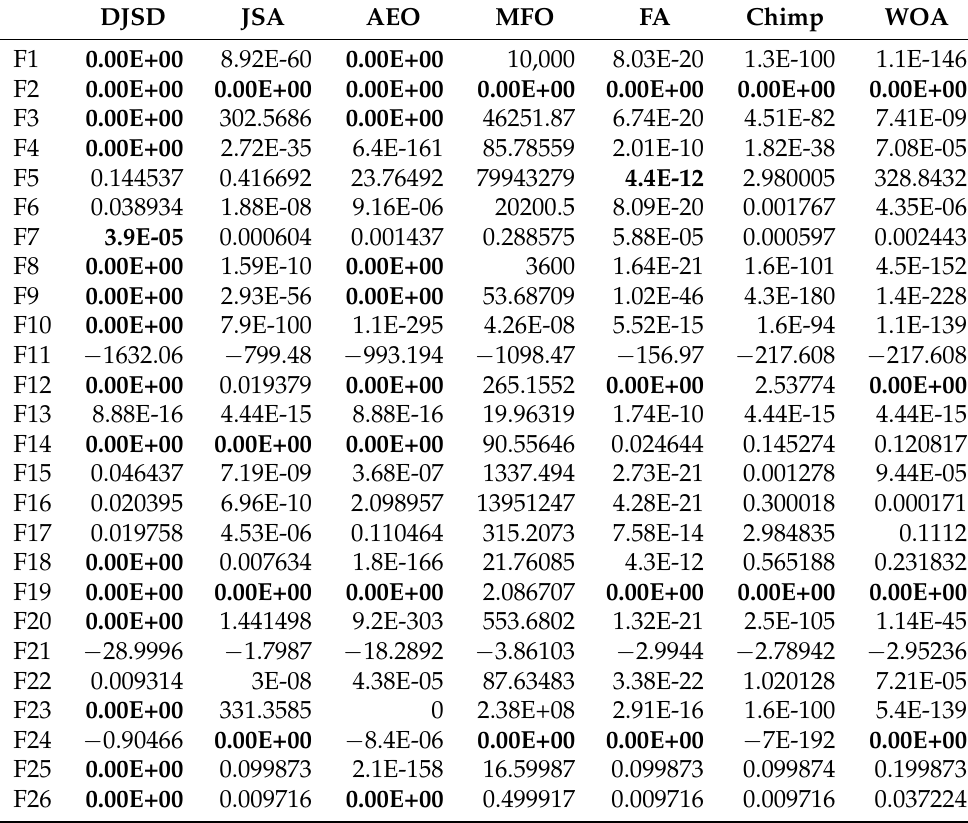
Table 6. Worst fitness values obtained by each